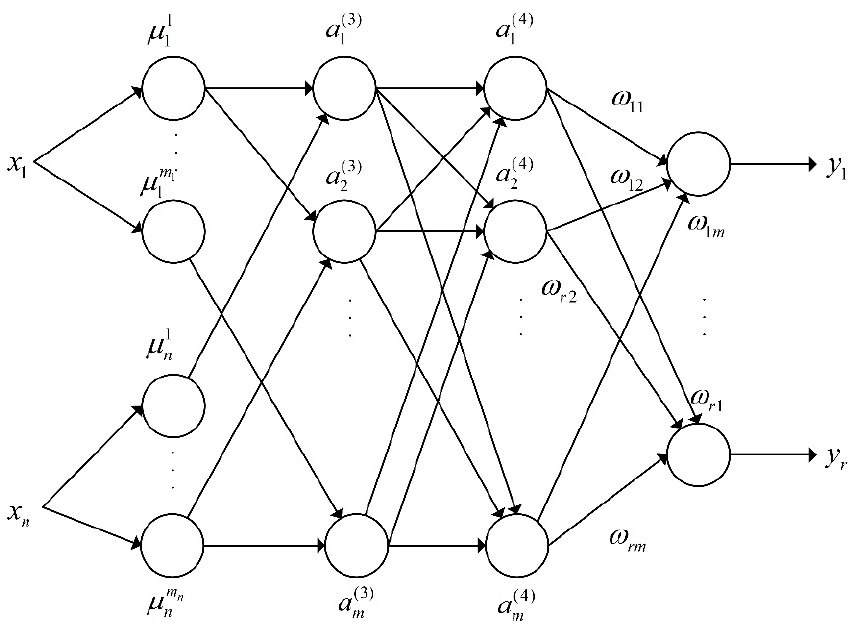
Figure 12. The structure of the fuzzy neural network.